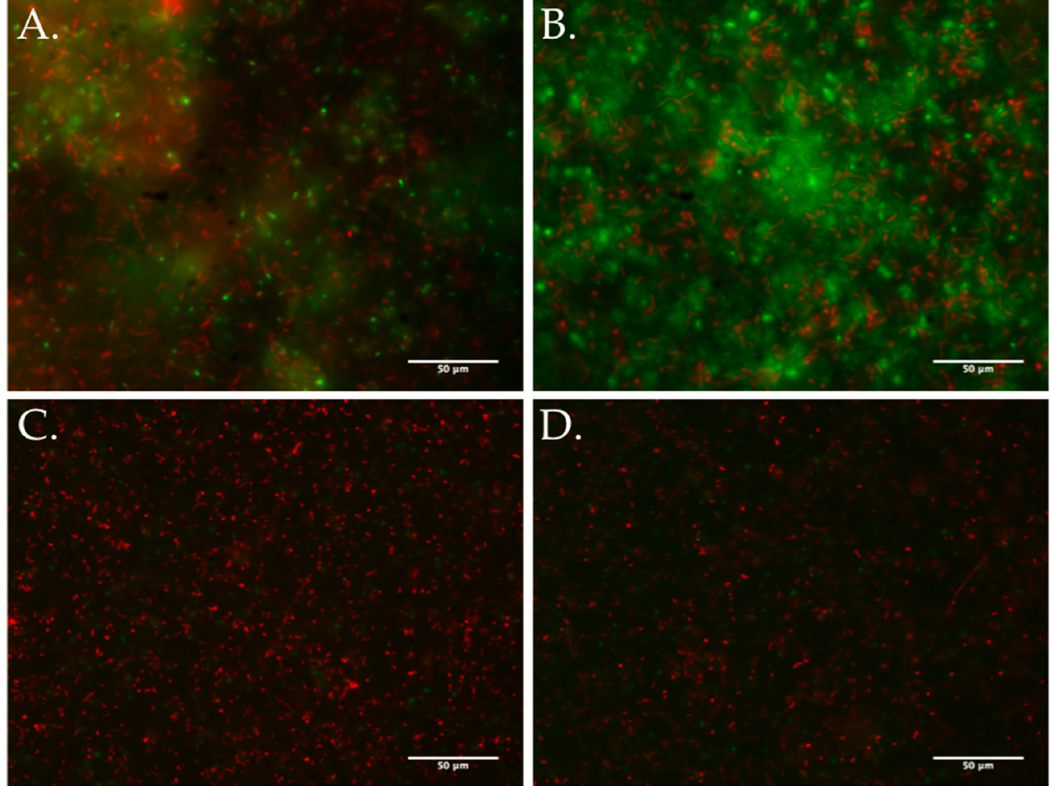
Figure 7. TOTO ‐ 1 Iodide 514/533 stain and SYTO60 red counterstain reveals extracellular DNA as a Figure 7. TOTO-1 Iodide 514/533 stain and SYTO60 red counterstain reveals extracellular DNA